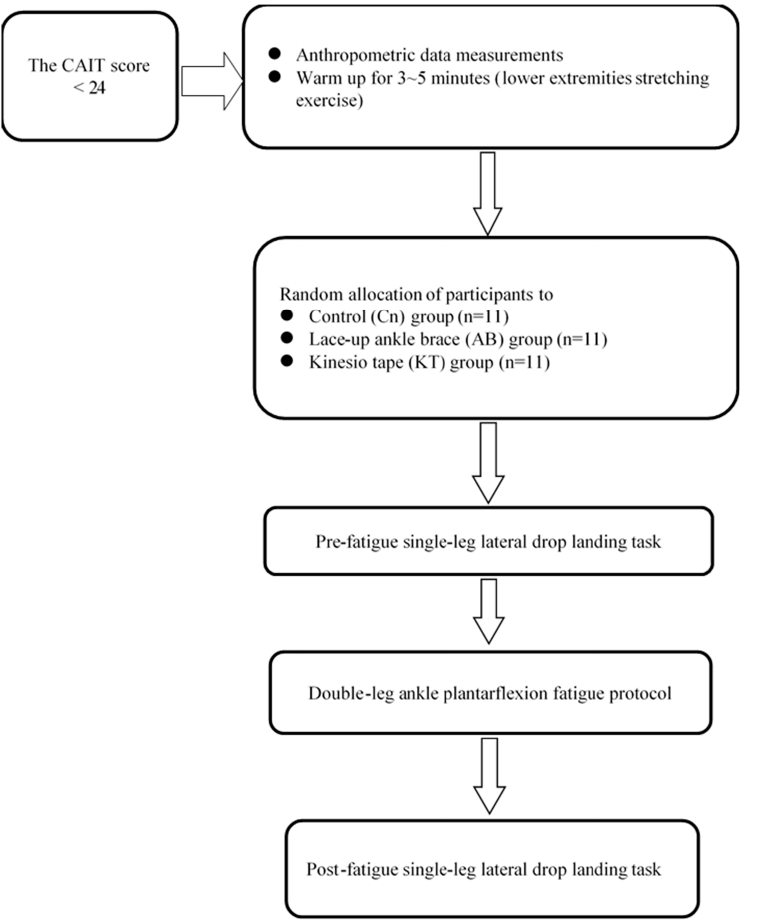
Figure 1. Flow chart of experimental procedure for Control (Cn), Ankle Brace (AB) and kinesio tape (KT) groups.